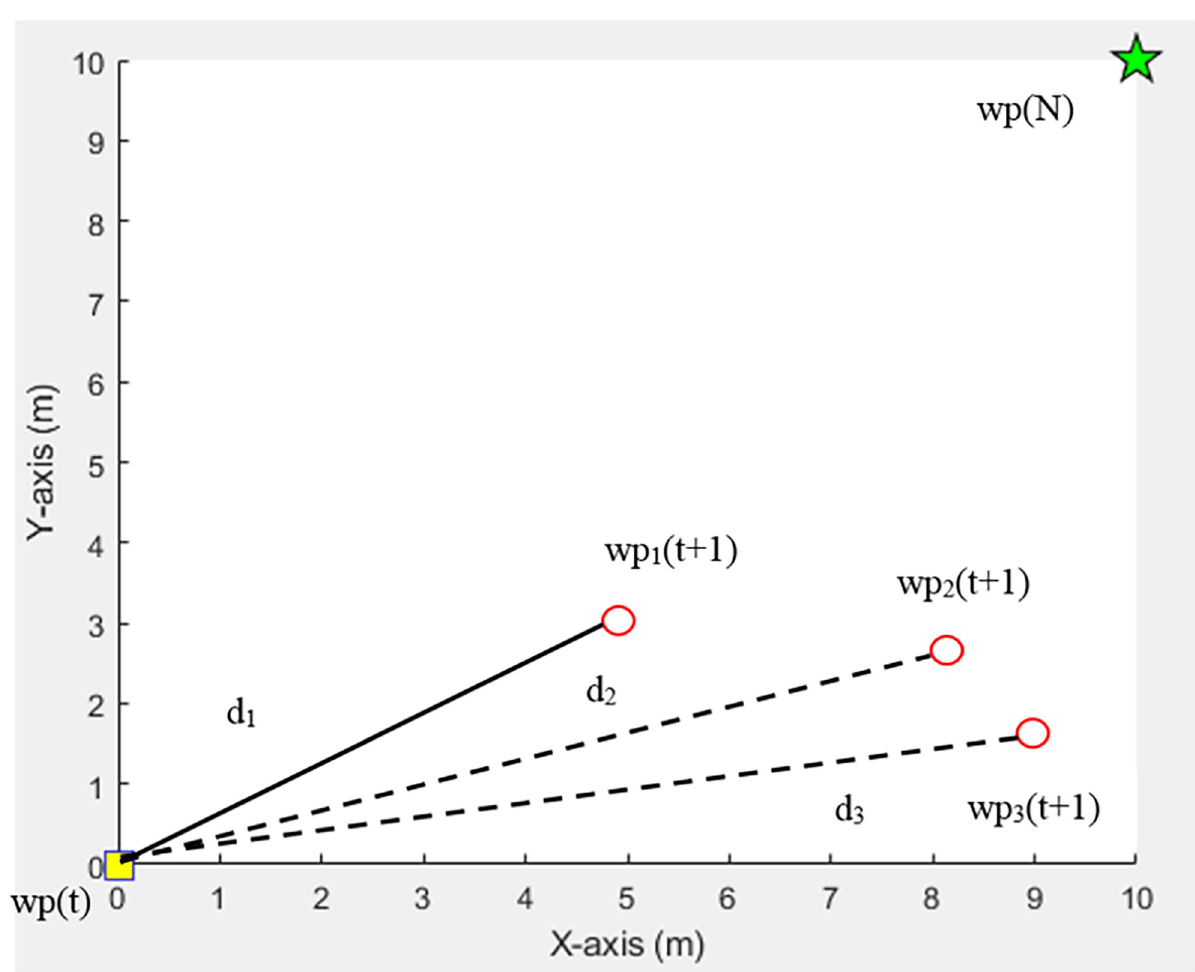
Fig 5. Consideration of the shortest